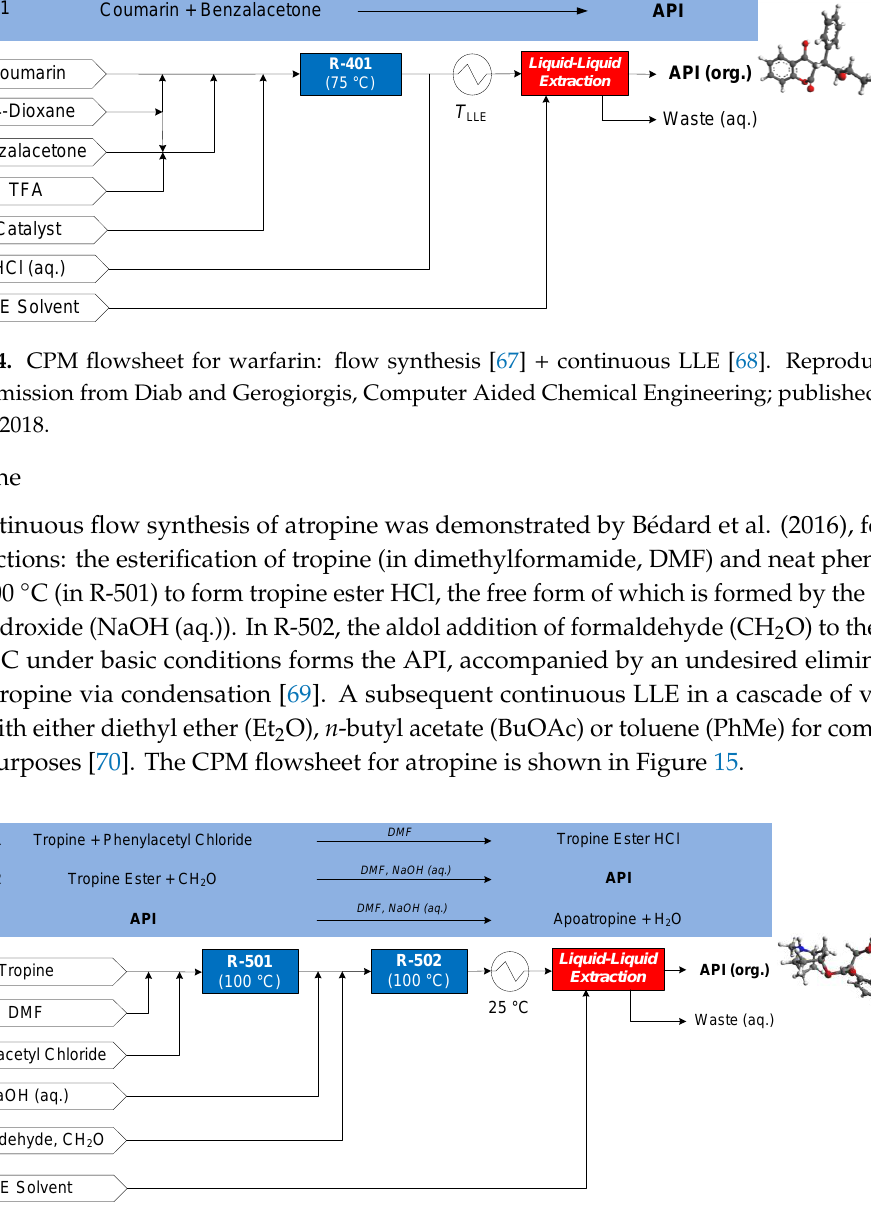
Figure 15. CPM flowsheet for atropine: flow synthesis [69] + continuous LLE [70]. Reproduced with permission from Diab and Gerogiorgis, AIChE Journal; published by John Wiley and Sons,